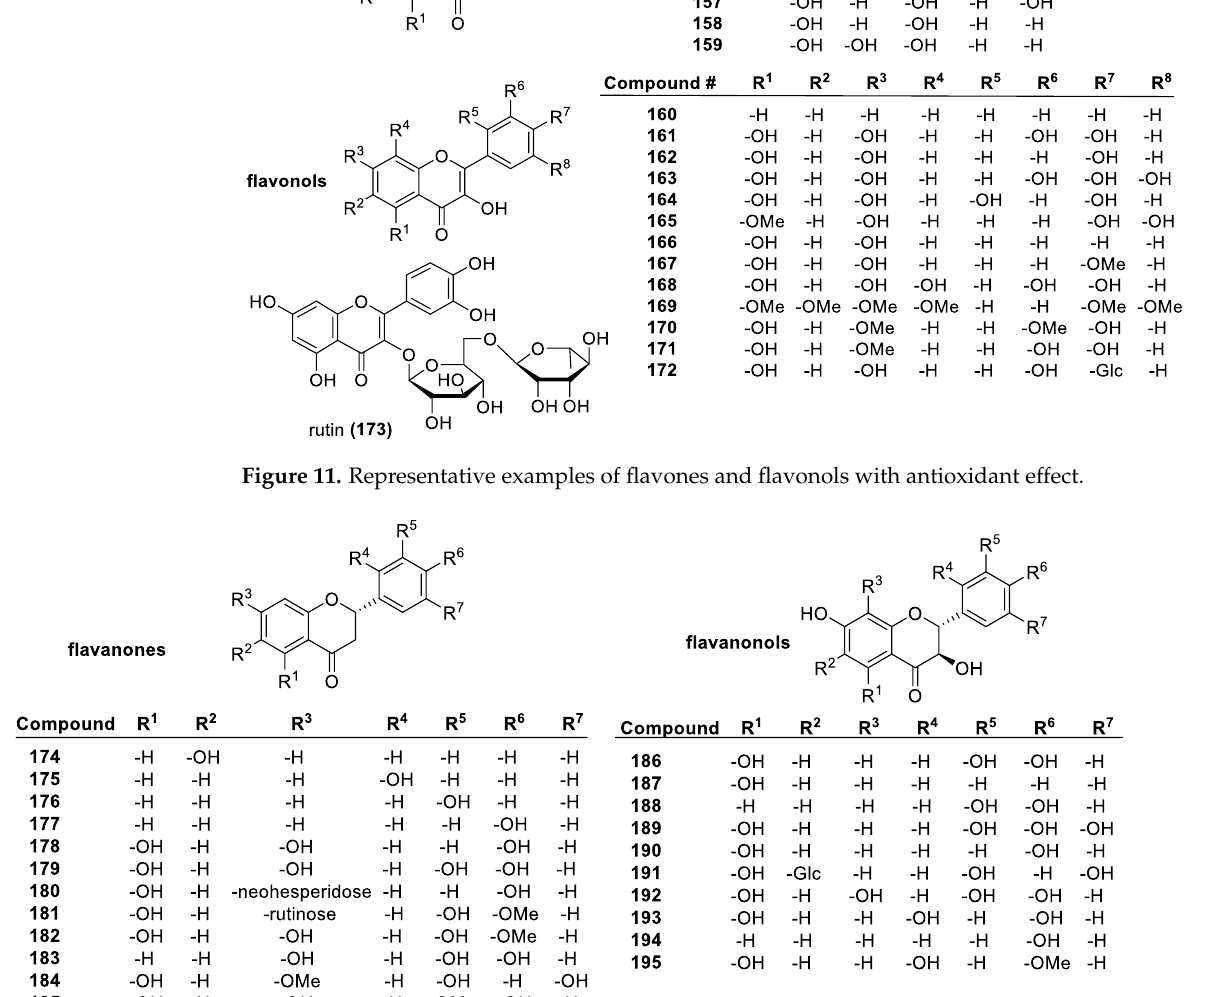
Figure 11. Representative examples of flavones and flavonols with antioxidant effect.